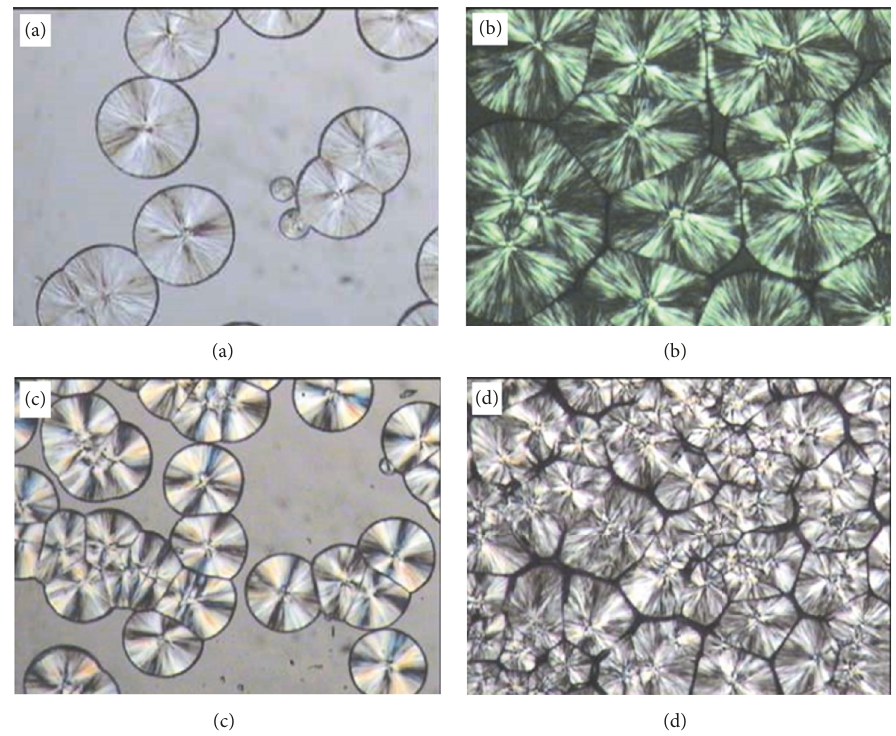
Figure 11: Isothermal crystallization images at 145 ∘ C during and at the end of the crystallization step for neat PP ((a) and (b)) and for 98 wt% PP/2wt% MCC ((c) and (d)) [magnification =